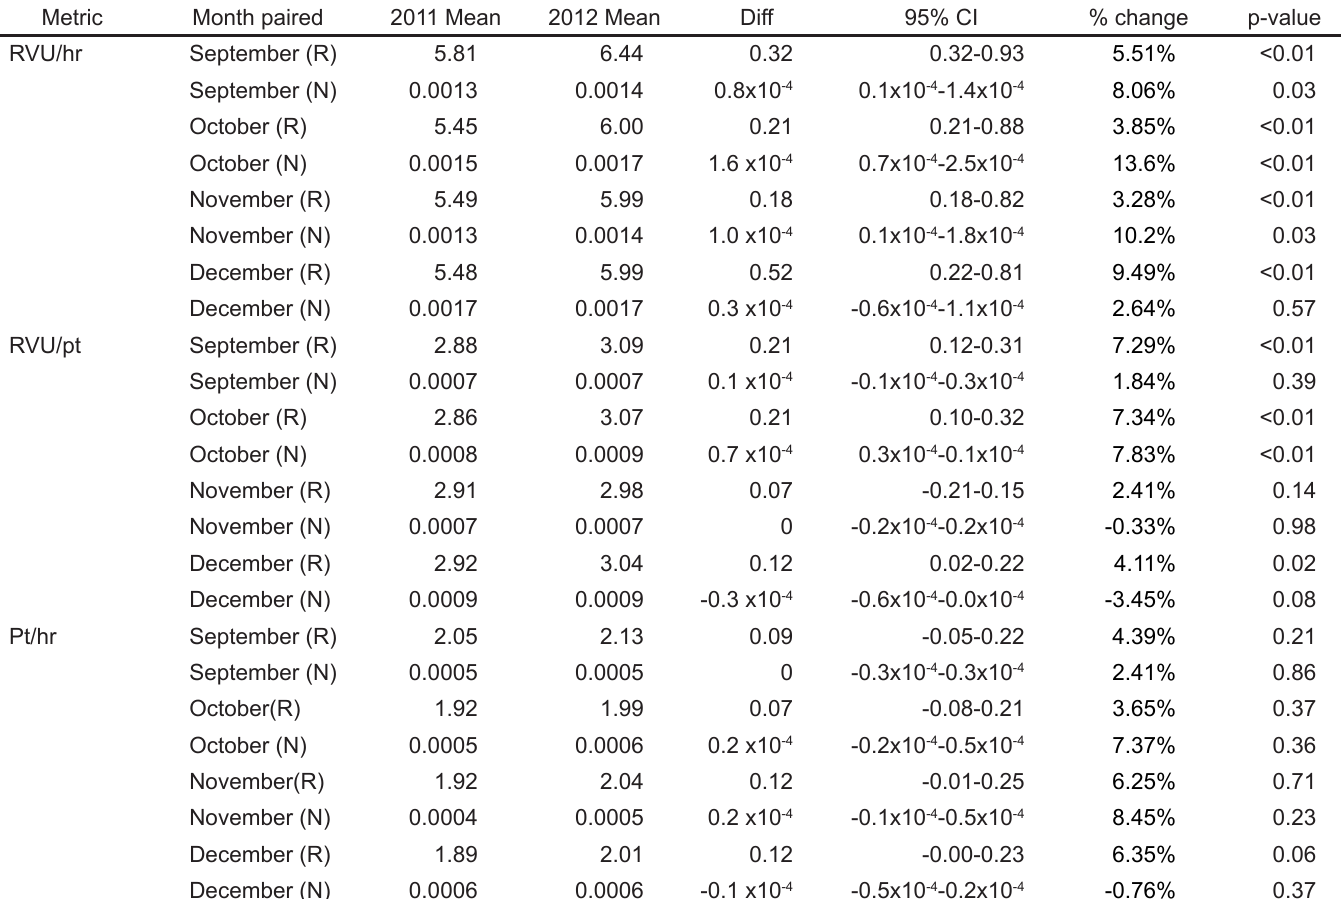
Table 3. Pre-post differences in seasonally-matched raw and normalized productivity metrics for the combined sample. Raw data are designated with an R and normalized with an N. Pair-wise comparisons could be done for all months for 62